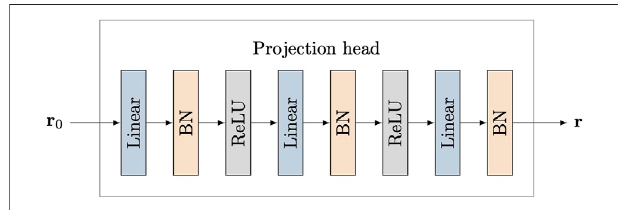
FIGURE 3 | Structure of projection head. Three linear layers are used and the fi rst two linear layers are followed with batch normalization (BN) and ReLU activation. The input of the projection head is the representation r 0 extracted from the encoder, and its output is the transformed representation r used for contrastive